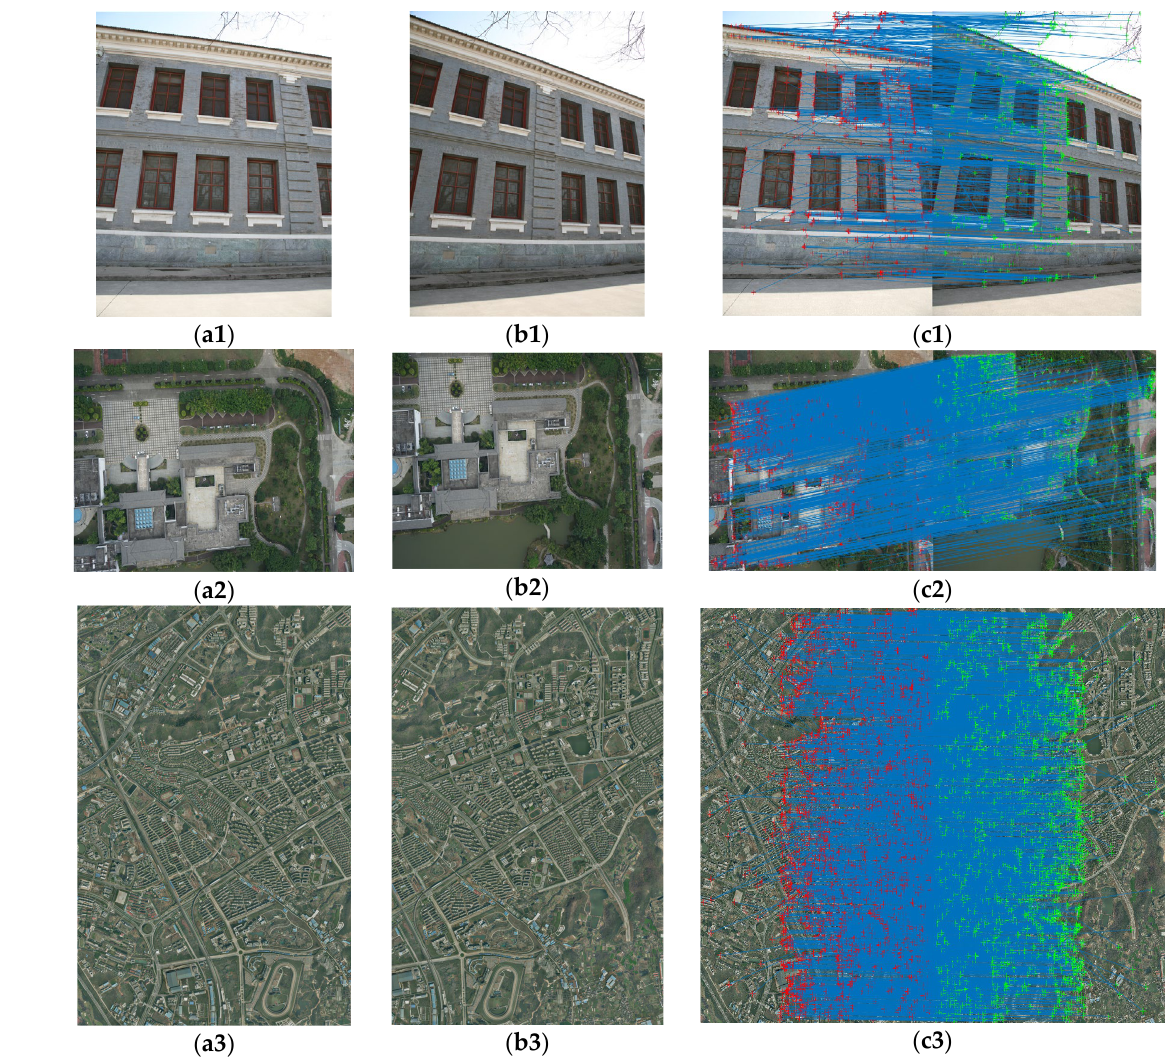
Figure 4. Data source. ( a1 , a2 , a3 ) are the left images, ( b1 , b2 , b3 ) are the right images, and ( c1 , c2 , c3 ) are the stitched images of the left and right images, in which two “+” symbols connected by a line are a pair of corresponding points.